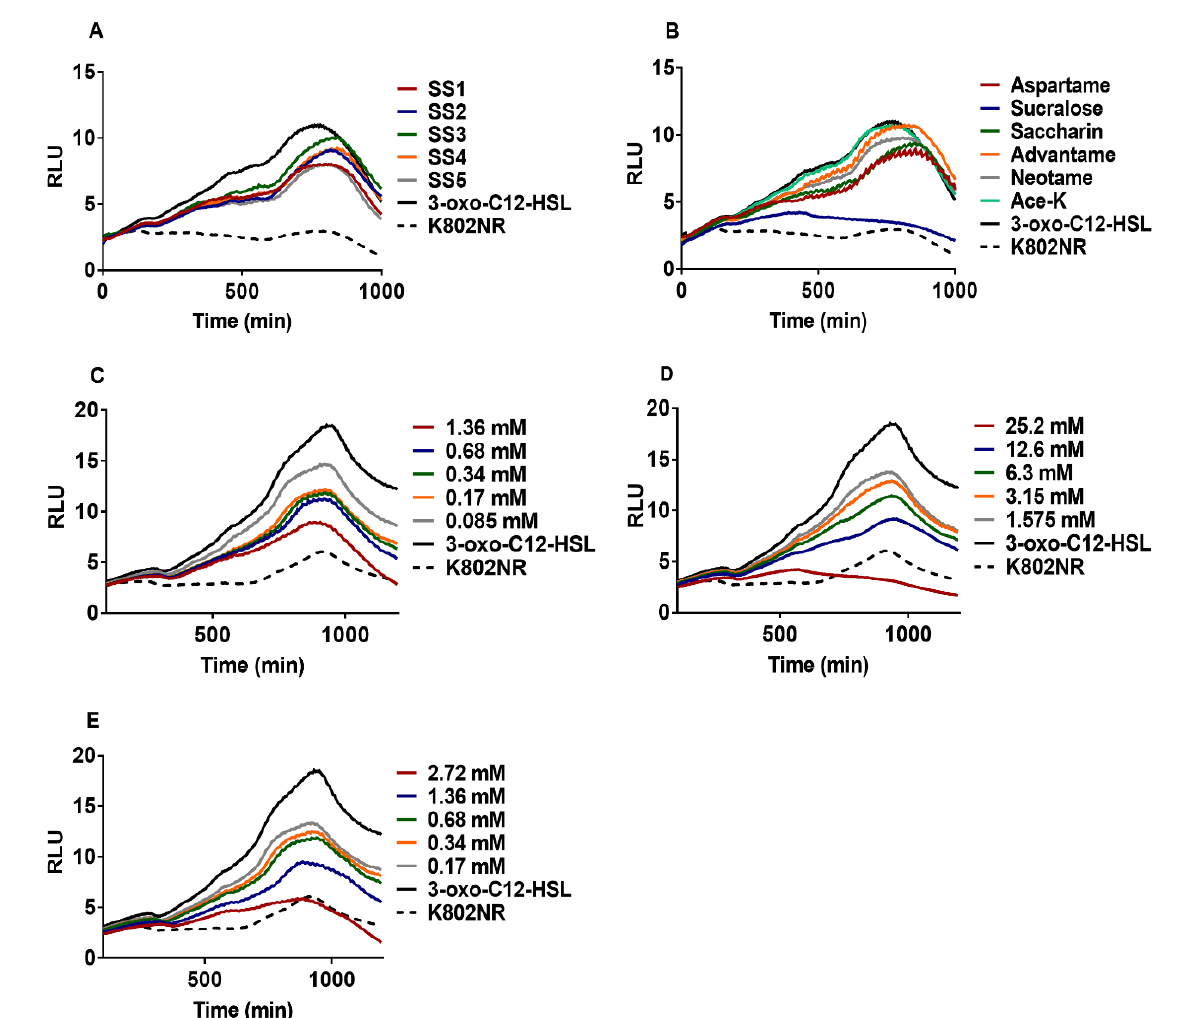
Figure 1. Anti-QS activity of artificial sweeteners. ( A ) Effect of different SS products on the K802NR bioreporter. SS1 (0.2 mg mL –1 ) contains sucralose, SS2 (0.4 mg mL –1 ) contains Ace-K and sucralose, SS3 (0.2 mg mL –1 ) contains Ace-K and sucralose, SS4 (0.3 mg mL –1 ) contains Ace-K and sucralose, and SS5 (0.3 mg mL –1 ) contains Ace-K and sucralose. The amounts of artificial sweeteners in the products are undisclosed. ( B ) Screening of six pure FDA-approved artificial sweeteners: aspartame (1.36 mM), sucralose (25.2 mM), saccharin (2.72 mM), advantame (0.42 mM), neotame (0.53 mM) and Ace-K (4.97 mM). ( C ) The response of K802NR to different concentrations of aspartame. ( D ) The response of K802NR to different concentrations of sucralose ( E ) The response of K802NR to different concentrations of saccharin. All concentrations of artificial sweeteners presented are final concentrations. The final concentration of 3-oxo-C12-HSL used was 5 × 10 –10 M. The luminescence of K802NR was expressed as RLU.